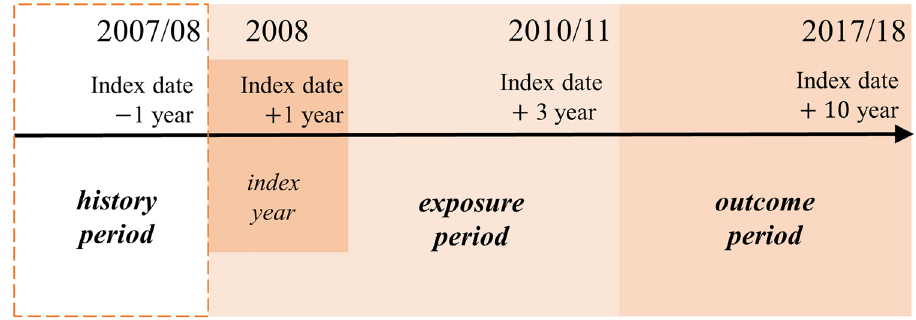
Figure 1. The schematic diagram of the time frame for